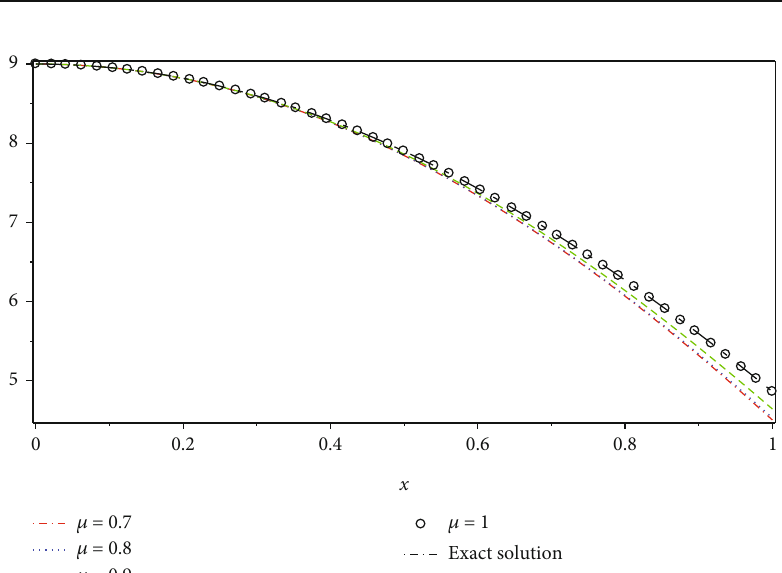
= k = 1, M = M = 4, and μ = 0 : 7, 0 : 8, 0 : 9, 1 at time ϑ = 3 for Example 1 2 1 2